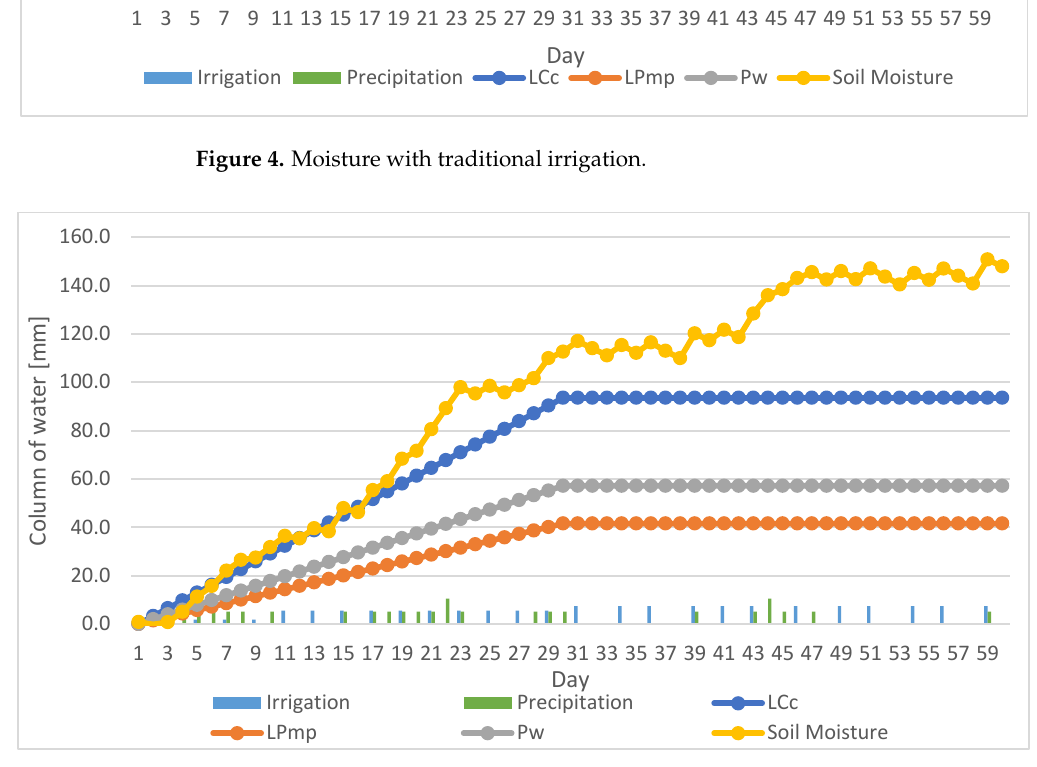
Figure 5. Moisture with technical irrigation.